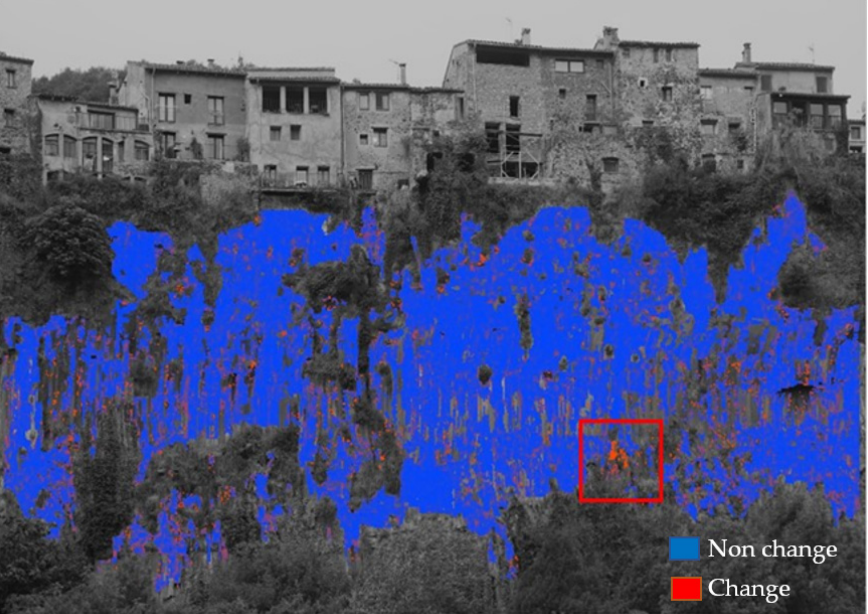
Figure 10. Volume change detection. In suspicious red pixels of change, their value of correlation is low. In blue, non-changed pixels with a high value of correlation.